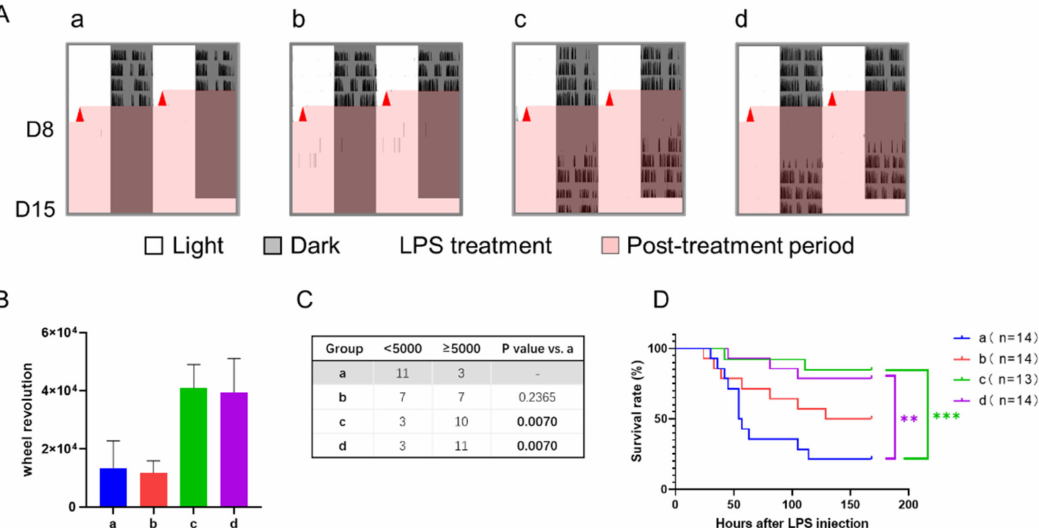
Figure 7. Effect of 12-h TRFs on behavior and health in mice treated with a 12-h delay phase shift and LPS injection. ( A ) Representative double-plotted actograms of wheel running activity after LPS treatment. ( B ) Total number of wheel revolutions after LPS injection. None of the groups were statistically different from each other. One-way ANOVA with Tukey’s multiple comparisons test.